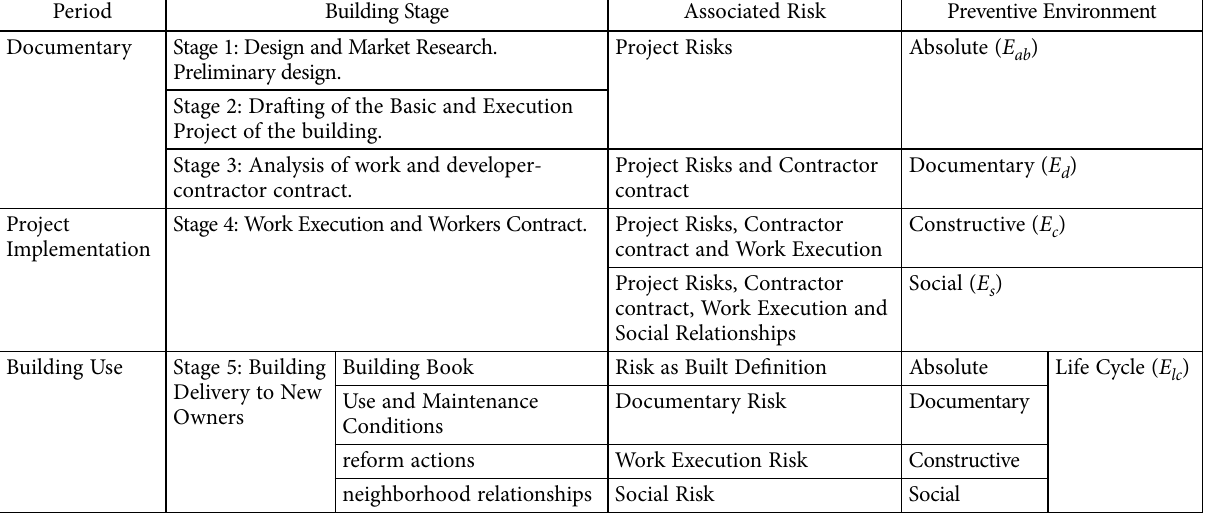
Table 3. Proposal environments preventive